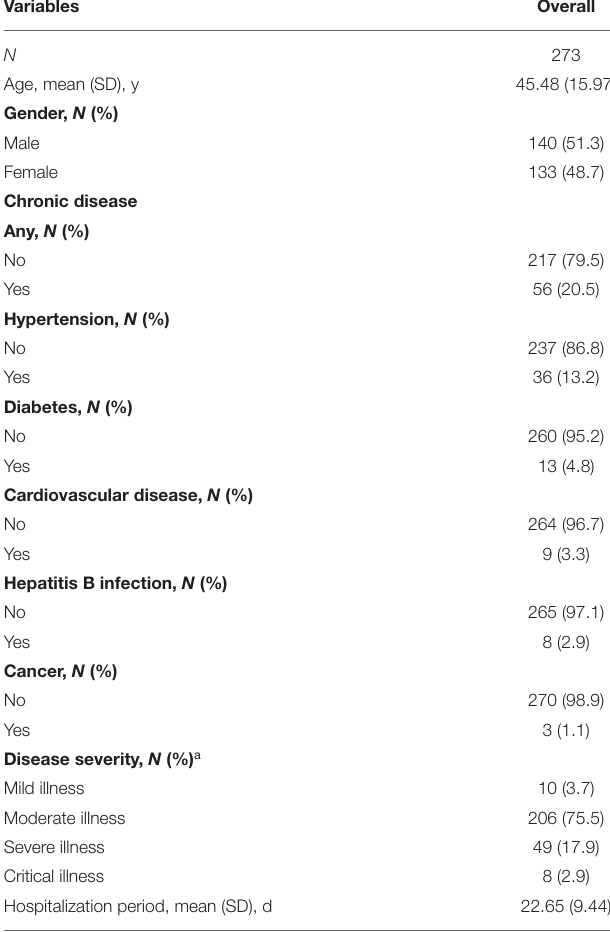
TABLE 1 | Clinical characteristics of 273 patients with COVID-19.